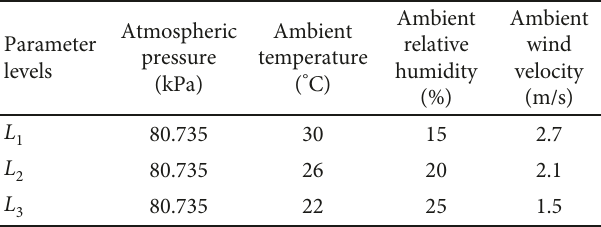
Table 2: Standard L